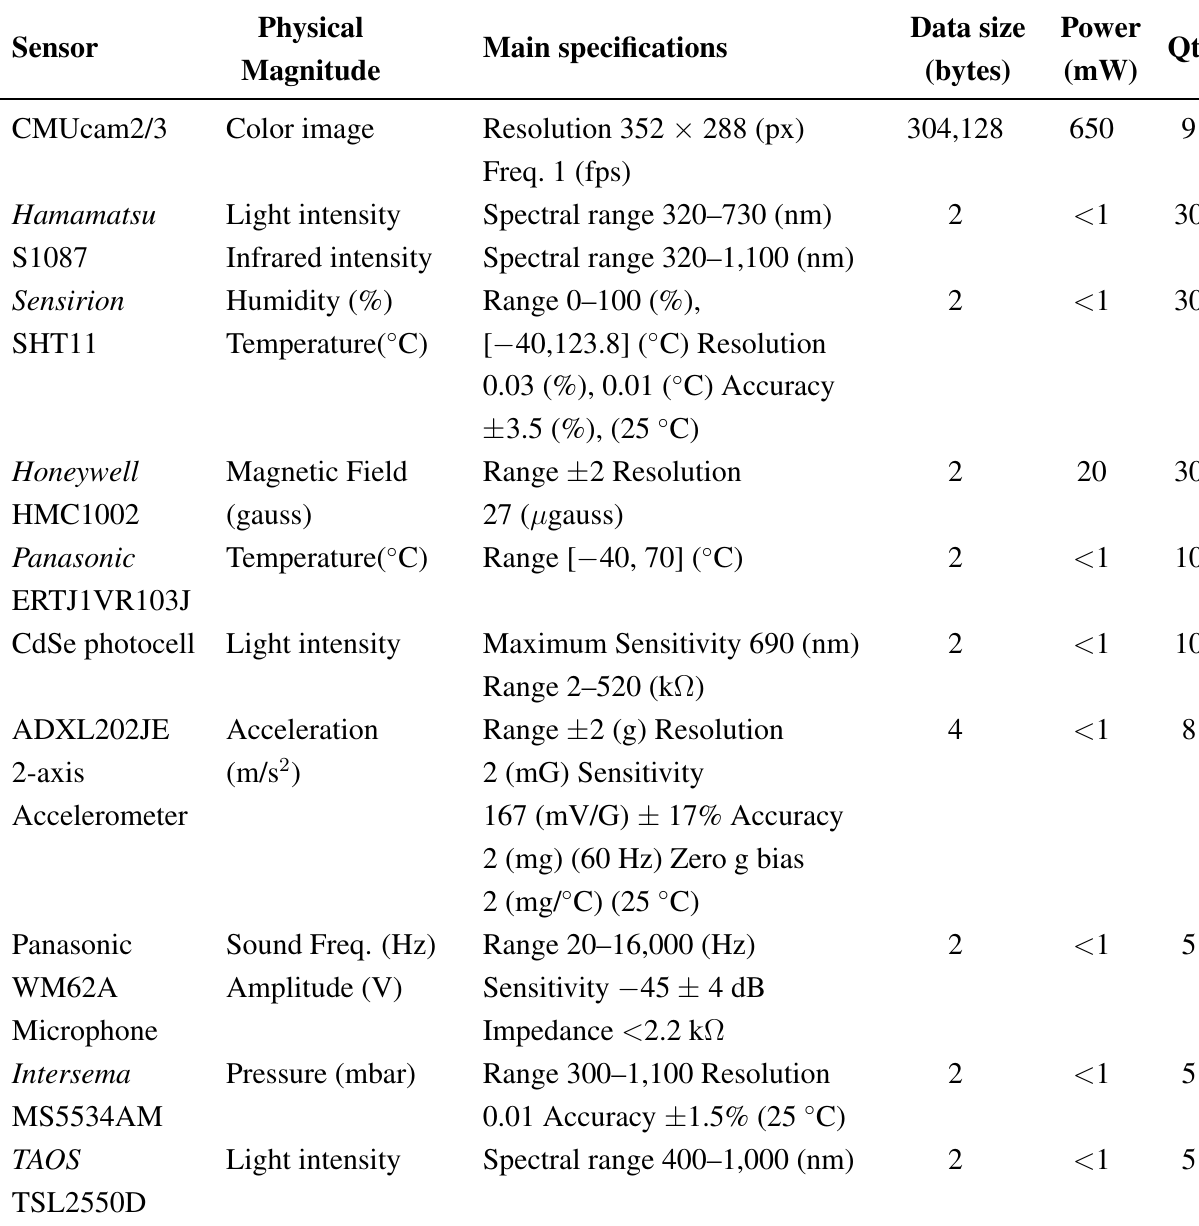
Table 3. Main features of WSN